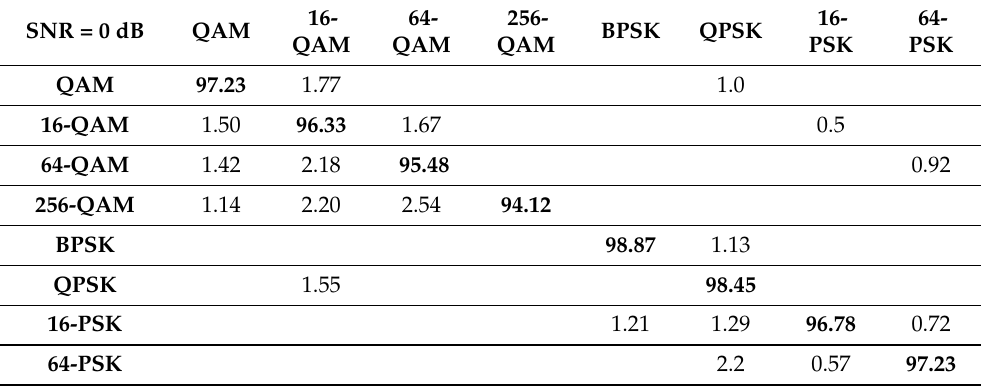
Table 4. Confusion matrix for 8-class problem.